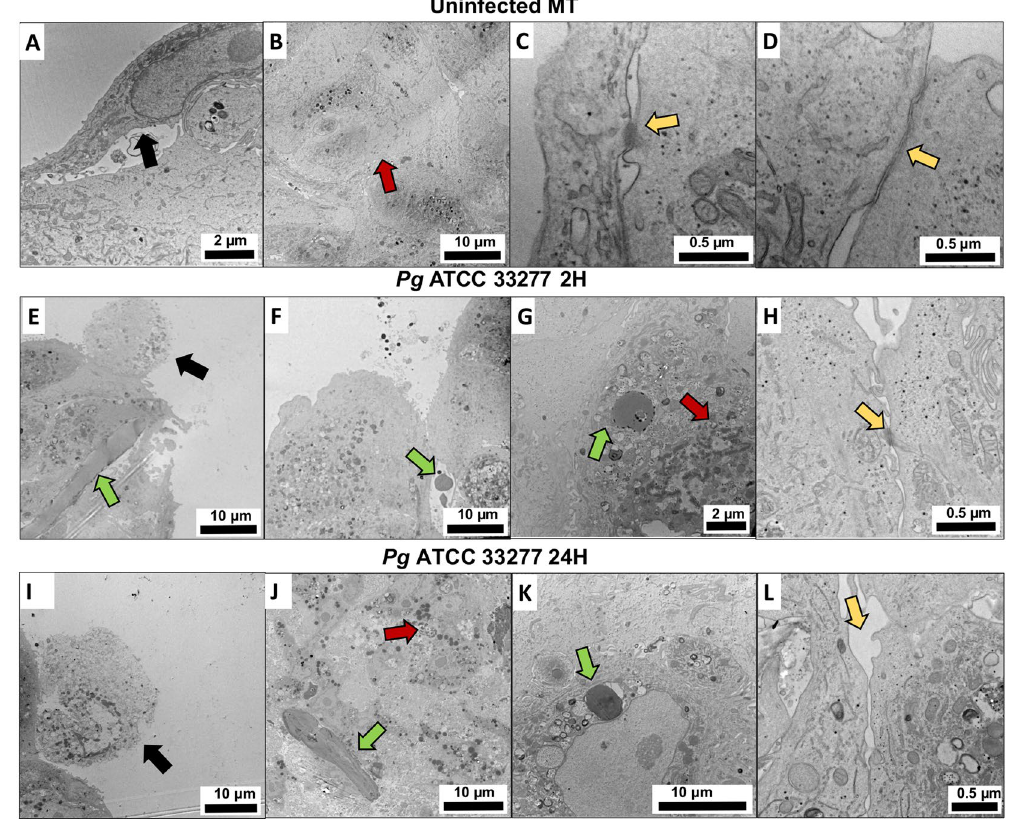
Figure 5. P. gingivalis induces fibroblastic stress and disruption of EC layer. TEM imaging of ( A – D ) uninfected MT, ( E – H ) MT infected with P. gingivalis for 2 h, ( M – O ) MT infected with P. gingivalis for 24 h. Green arrows indicate P. gingivalis bacterial infection and intercellular/intracellular invasion; black arrows indicate apoptotic cells and signs of acute cellular stress; red arrows indicate an acute cellular stress in FBs and the presence of lysosomes and apoptosis correlated with bacterial invasion; yellow arrows indicate several epithelial junctions such as desmosomes, long and short tight junctions between